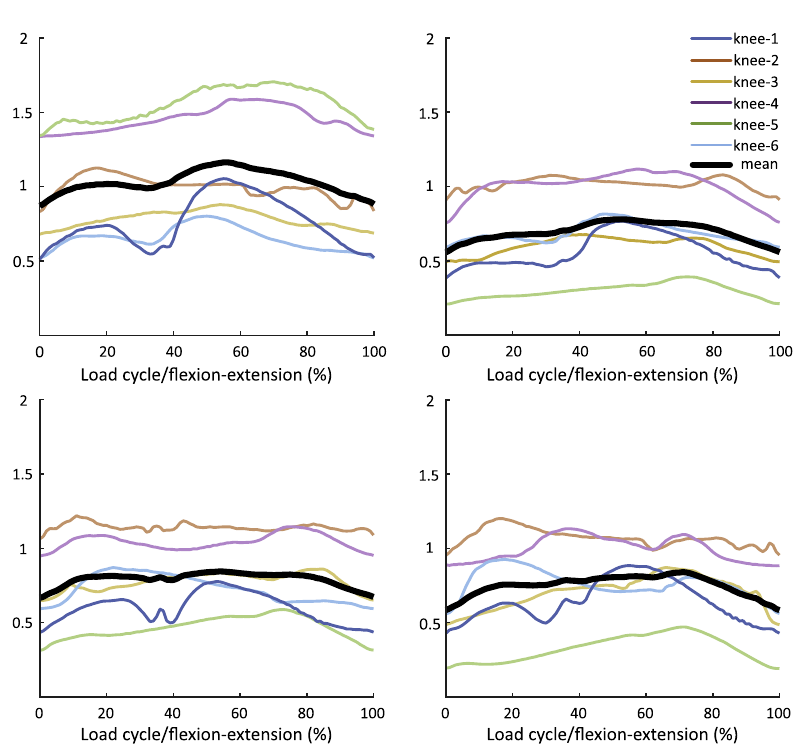
Figure 5. Mean stress progression. Time series representing mean stress progression of the individual tested knee models (1–6) with the corresponding spacer